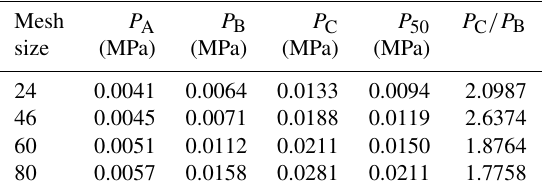
Table 1. Pressure characteristic values of four permeable stones with different particle sizes.